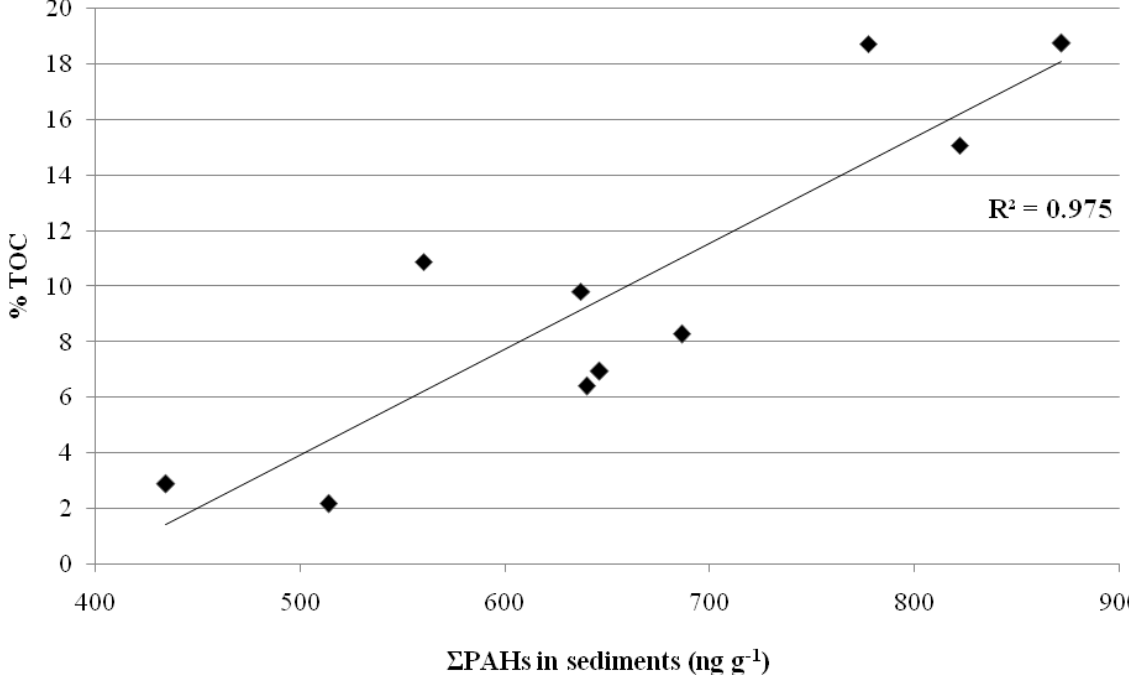
Figure 2. Relationship between the total organic carbon (%TOC) and Σ PAHs in the sediment samples of the Volturno River.